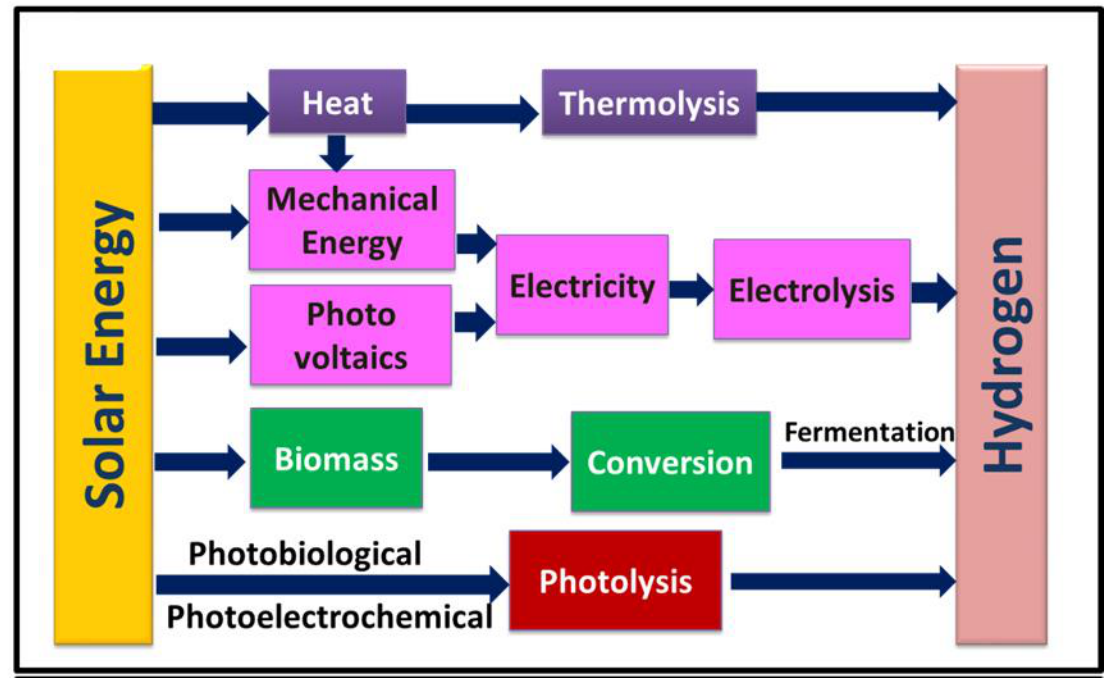
Figure 1. Schematic representation of various strategies of H 2 production from solar radiation.